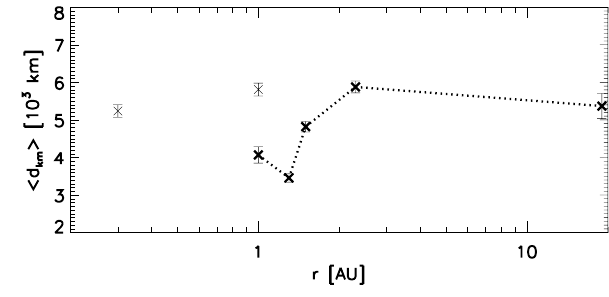
Fig. 12. Radial dependence of the fit parameter ω s for the overall distribution (solid), the B criterion (dotted) and the TS (dashed).